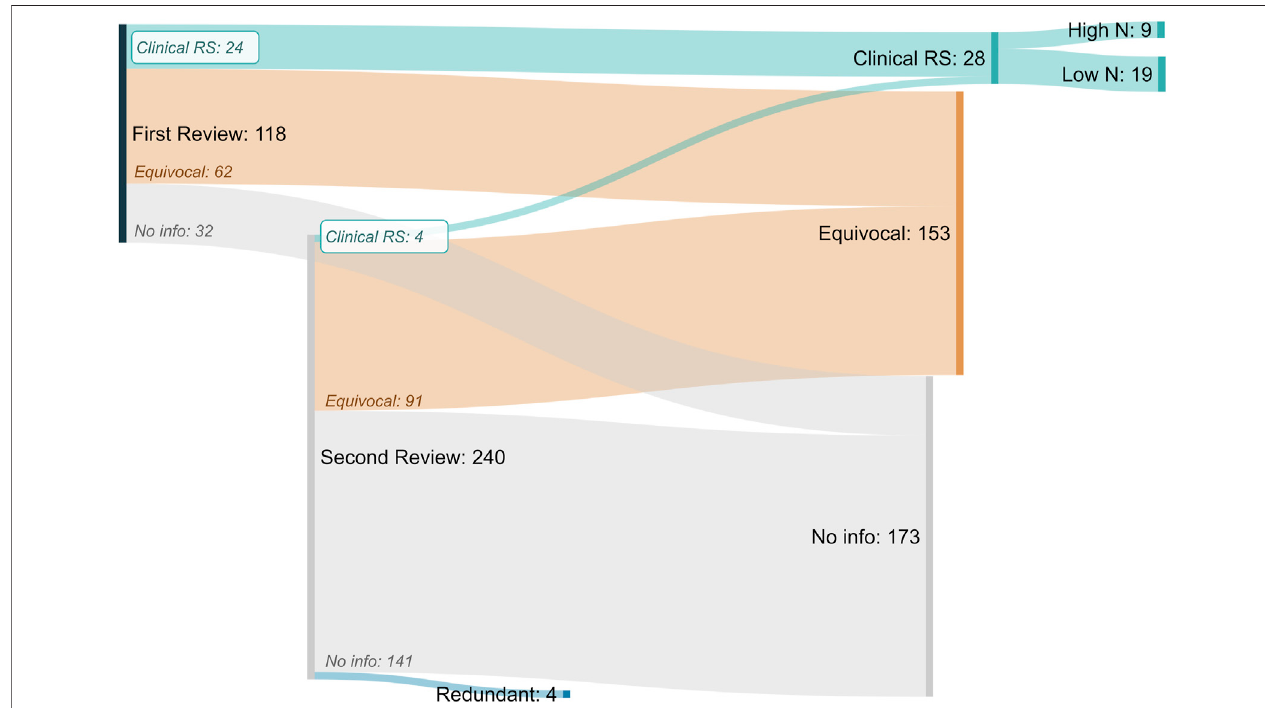
FIGURE 4 | Sankey Diagram of “ in litero ” screening results for all putative respiratory sensitizers and related compounds. From the original review of 118 putative sensitizers, 24 clinical respiratory sensitizers (Clinical RS) were identi fi ed. An additional automated search for similarly reported chemicals identi fi ed 240 chemicals, resultingintheidenti fi cationof4moreclinicalrespiratorysensitizers.Fornineofthetotal28clinicalrespiratorysensitizersidenti fi ed,wefoundcasereportsdemonstrating respiratory sensitization in greater than ten total patients (High N). For the remaining 19, at least one case of clinical respiratory sensitization was identi fi ed (Low N). Inconclusive (Equivocal) evidence suggestive of clinical respiratory sensitization was found for an additional 153 chemicals.